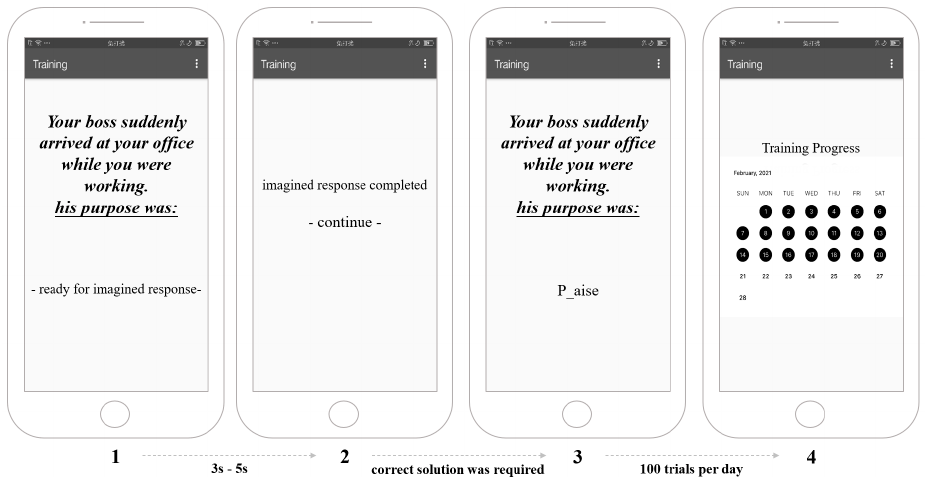
Figure 1. Smartphone-based interpretation-bias modification training.